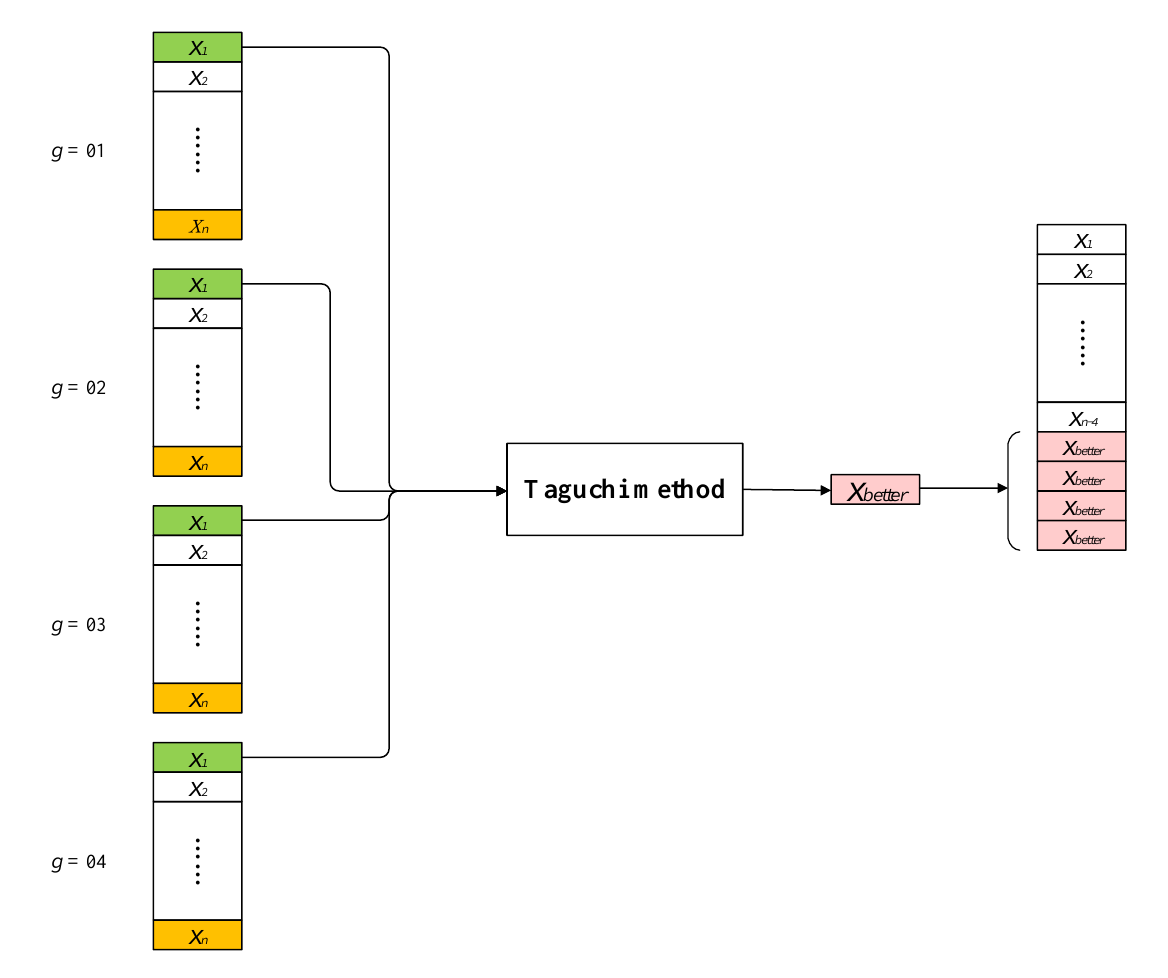
Figure 3. The new communication strategy 2.